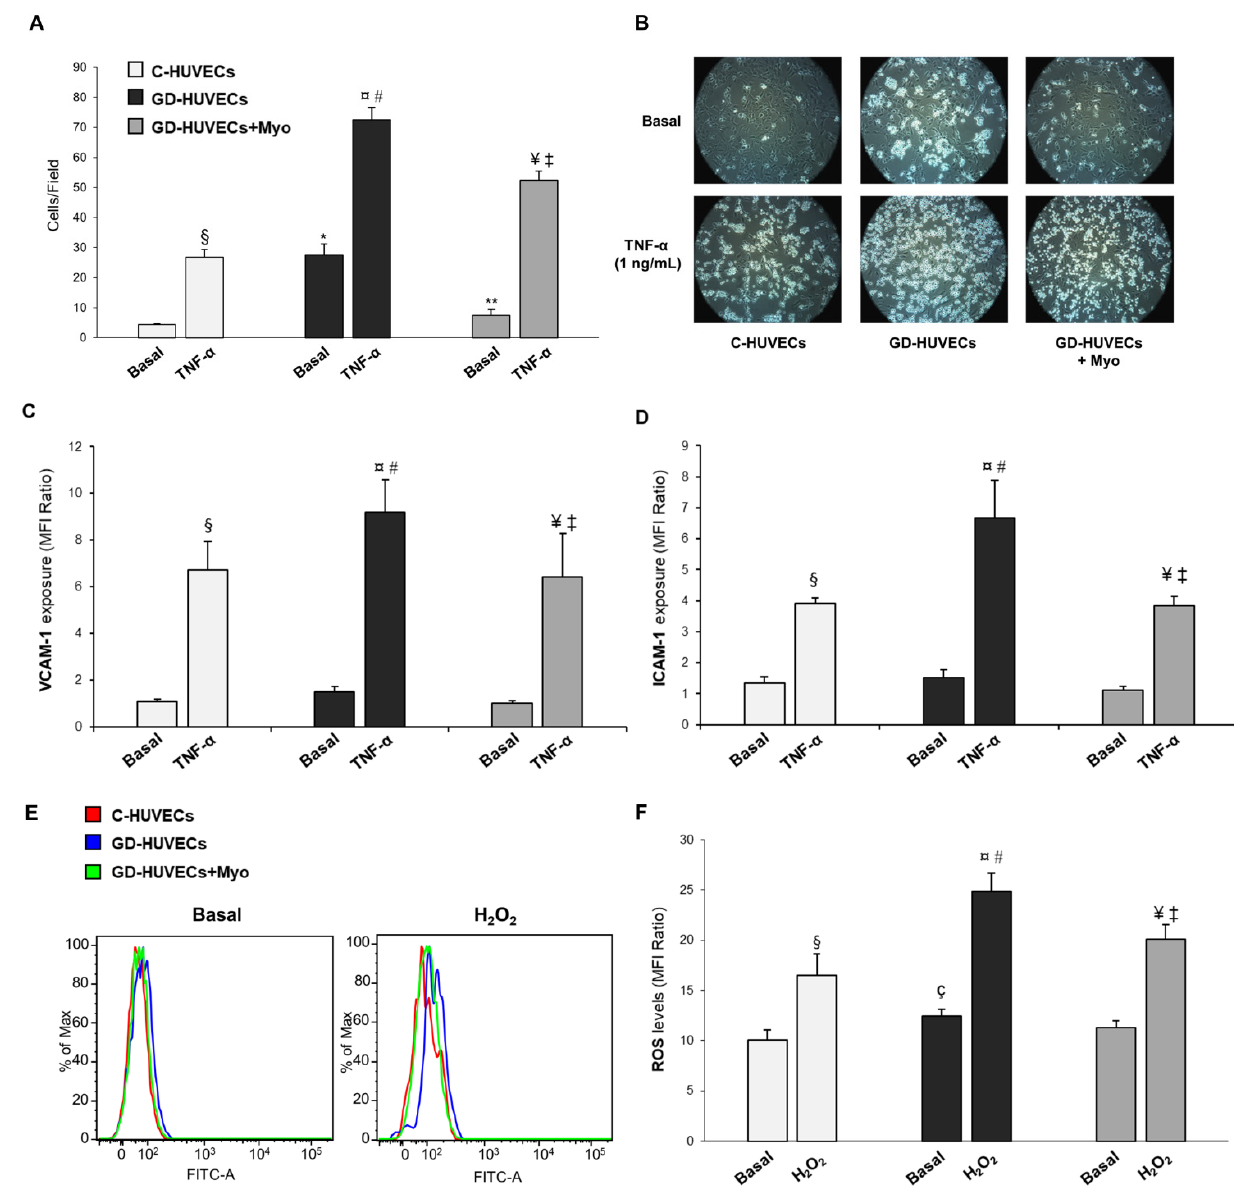
Figure 1. Effect of supplementing GD mothers with Myo during pregnancy on GD-HUVECs in vitro features. ( A ) Effect of in vivo treatment with Myo on U937 monocyte adhesion to the endothelium. ( B ) Representative pictures of C-, GD- and GD+Myo-HUVECs for each experimental condition. ( C , D ) Effect of in vivo Myo treatment on adhesion molecule membrane exposure (VCAM-1, panel C and ICAM-1, ( D ). ( E ) Representative histograms obtained from the cytometric analysis for Basal condition and after H 2 O 2 treatment. ( F ) Effect of Myo in in vivo treatment on ROS levels in endothelial cells. * p < 0.01 vs. Basal C-HUVECs; ** p < 0.01 vs. Basal GD-HUVECs; § p < 0.05 vs. Basal C-HUVECs; ¤ p < 0,05 vs. Basal GD-HUVECs; ¥ p < 0,05 vs. Basal GD-HUVECs + Myo; # p < 0.05 vs. TNF- α C-HUVECs; ‡ p < 0.05 vs. TNF- α GD-HUVECs; ç p < 0.05 vs. Basal C-HUVECs.